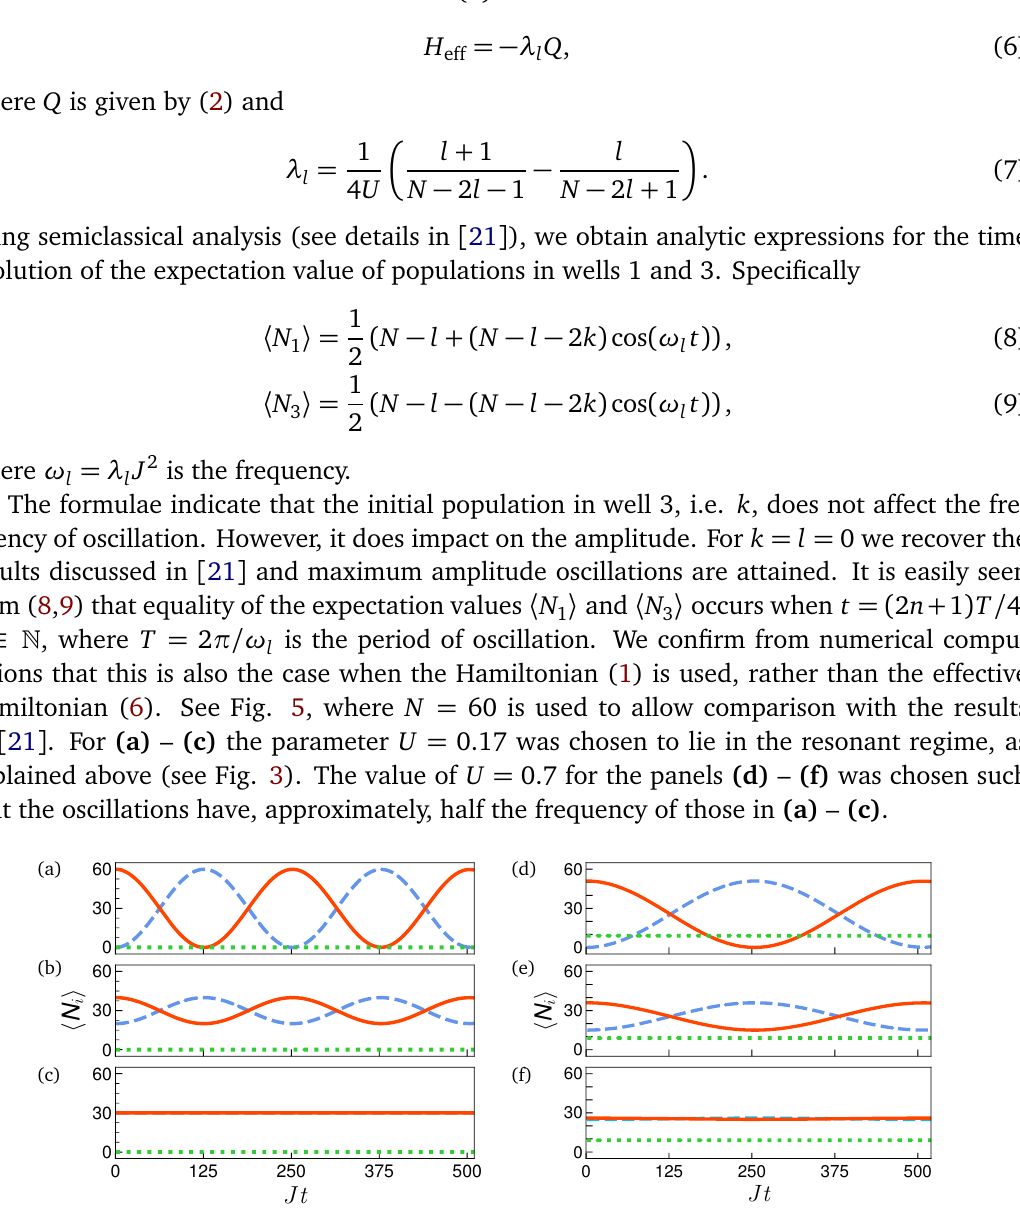
Figure 5: Expectation value dynamics. Dimensionless units are used. We set J = 1 and N = 60. The left panels are for U = 0.17 and the initial states : | 60,0,0 〉 [ 21 ] , | 40,0,20 〉 and | 30,0,30 〉 . The right panels are for U = 0.7 and the initial states: | 51,9,0 〉 , | 36,9,15 〉 and | 26,9,25 〉 . The solid red line is for 〈 N 〉 , the dotted green 1 〉 and the dashed blue line is for 〈 N 〉 line is for 〈 N 2 3